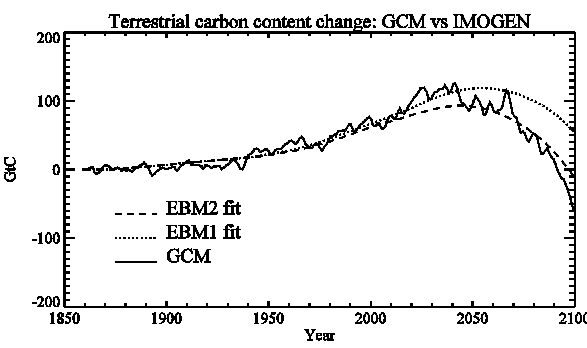
Figure 3: IMOGEN EBM1 and EBM2 calculations (dotted and dashed lines, respectively) of change in total terrestrial carbon (both vegetation and soil, and across all land points except Antarctica) from 1860. Also plotted is the same quantity (continuous line) as predicted by HadCM3LC. As for Figure 2 in all cases, the models are forced by the SRES A2 emissions scenario, but adopting only the carbon dioxide component (i.e. no non-CO 2 GHGs).